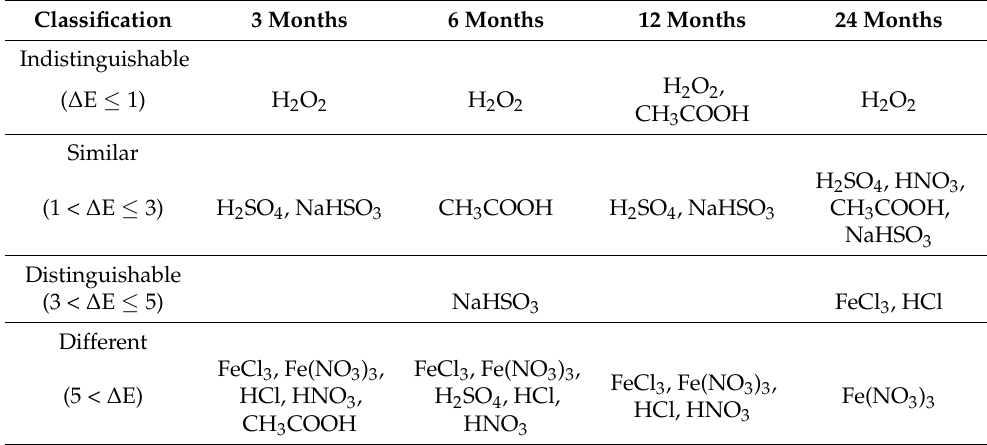
Table 6. Scale for classification differences in ∆ E between natural patina, used as a reference, and accelerated patinas after 3, 6, 12 and 24 months of atmospheric